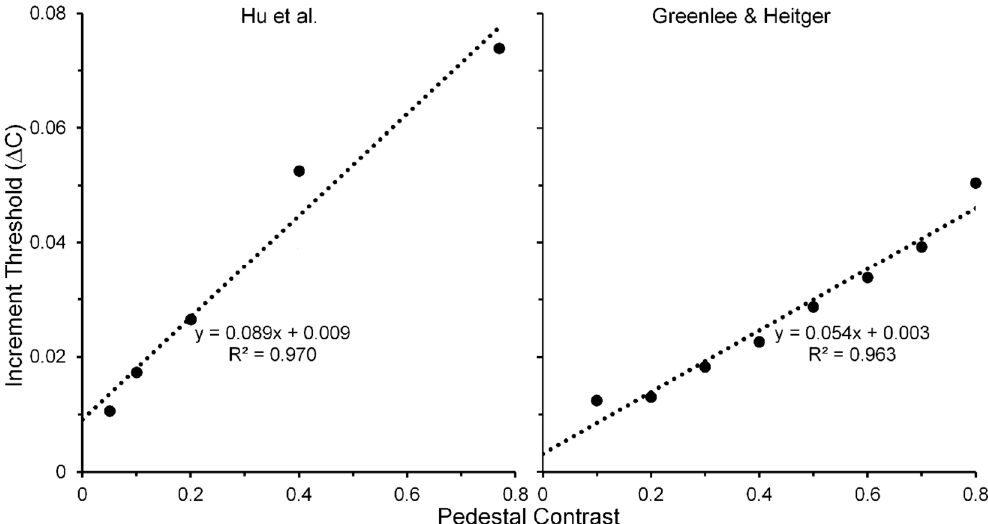
Figure 7. Thresholds for detecting a contrast increment on a pedestal mask as a function of the pedestal contrast. See text for details of how the depicted data points were obtained. See text for details of how the depicted data points were obtained. Adapted from [68] and from [70] with permission from the publisher.